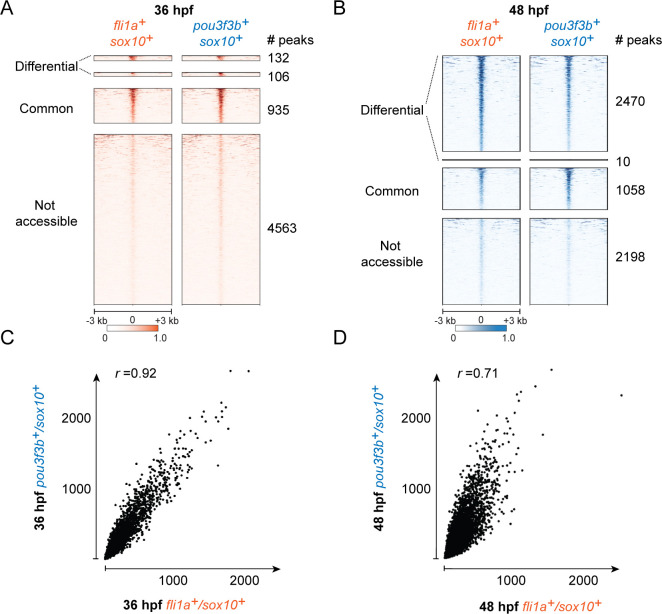
Accessibility of cartilage-enriched elements in earlier pan- and dorsal CNCCs.(A,B) Heatmaps of the 5,736 distal elements with accessibility in 72 hpf chondrocytes. Their accessibility is then plotted according to μATACseq data from fli1a:GFP+; sox10:Dsred+ (pan-CNCCs) and pou3f3b>GFP+; sox10:Dsred+ (dorsal CNCCs) at 36 hpf (A) and 48 hpf (B). At 36 hpf, 132 peaks were more accessible in pan-CNCCs and 106 peaks more accessible in dorsal CNCCs. At 48 hpf, 2,470 peaks were more accessible in pan-CNCCs and 10 peaks more accessible in dorsal CNCCs. Peaks commonly or not accessible in both data sets are also shown. (C,D) Pearson correlation graphs of the behavior of cartilage-associated distal elements in pan- versus dorsal CNCCs at 36 and 48 hpf. x and y axes represent raw read counts from BAM files, and ‘r’ is the Pearson correlation coefficient.